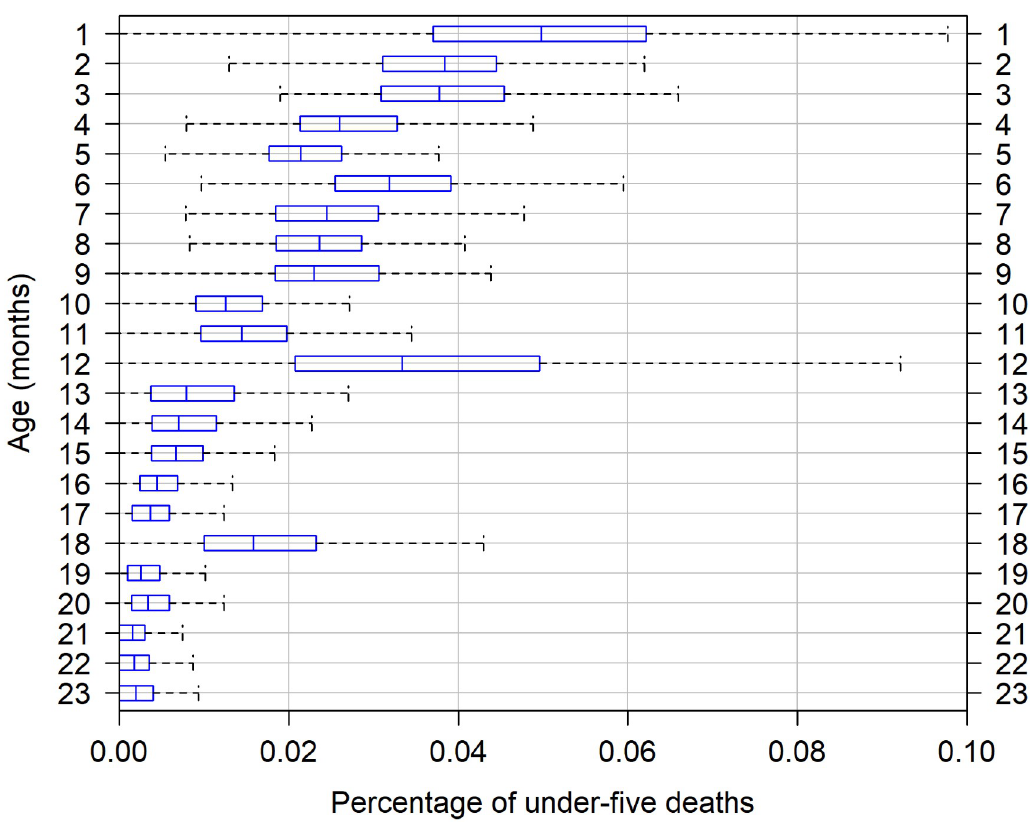
Fig 2. Cumulative probability of dying from birth to age x for the Bolivia 1989